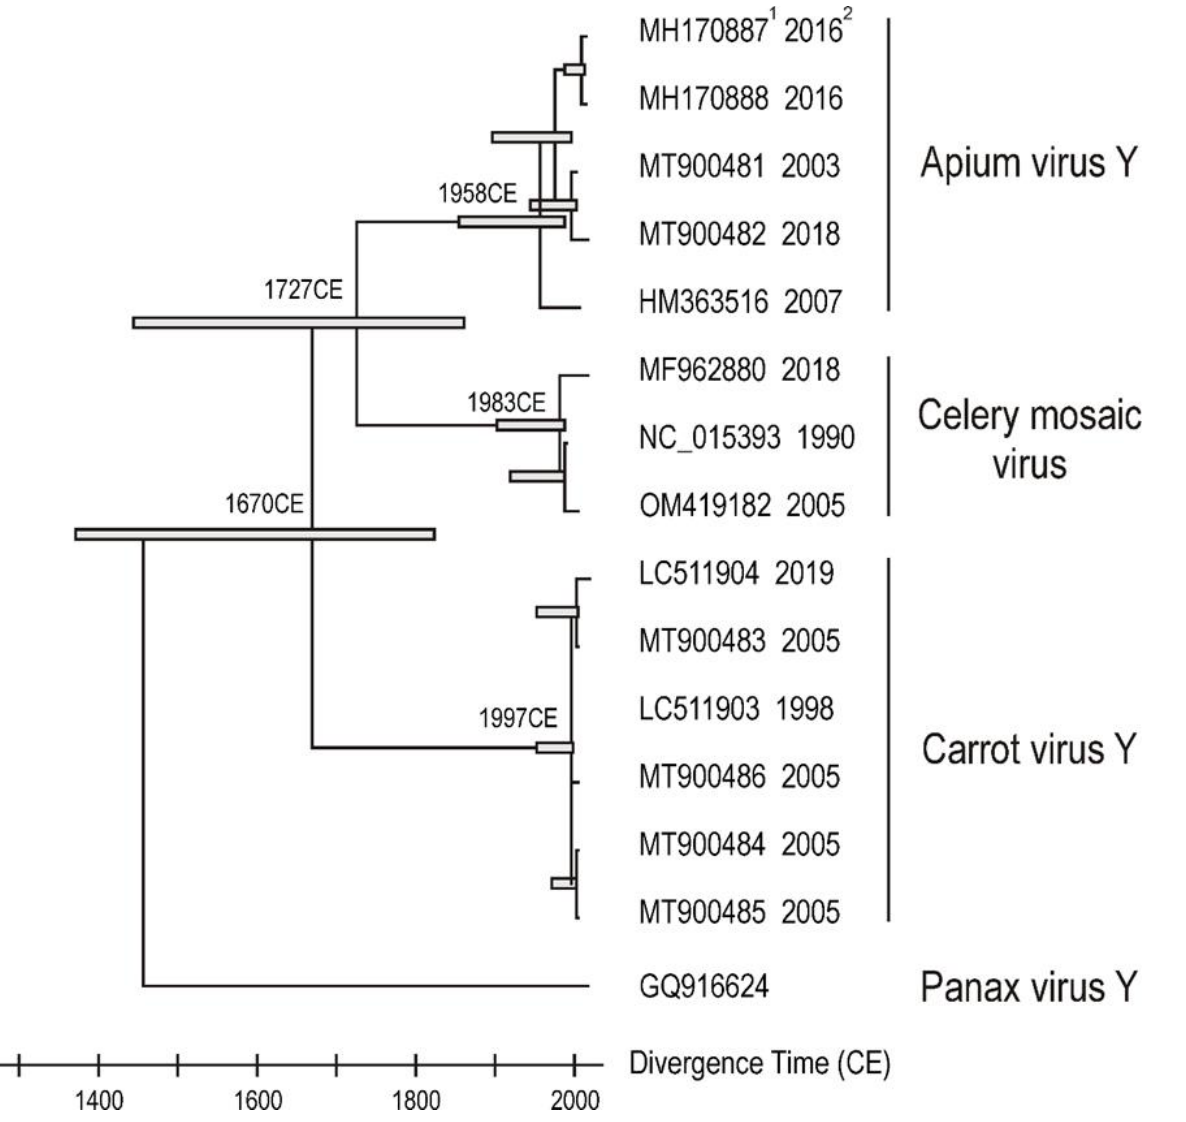
Figure 2. A dated phylogeny of the 14 CeMV lineage sequences for which there are known ‘collection dates and complete genome sequences. The accession codes of the sequences (1), and the collection dates of the isolates (2) are shown. The analysis was done using the RTDT method in Mega 11. The error bars for the major nodes are two standard errors.